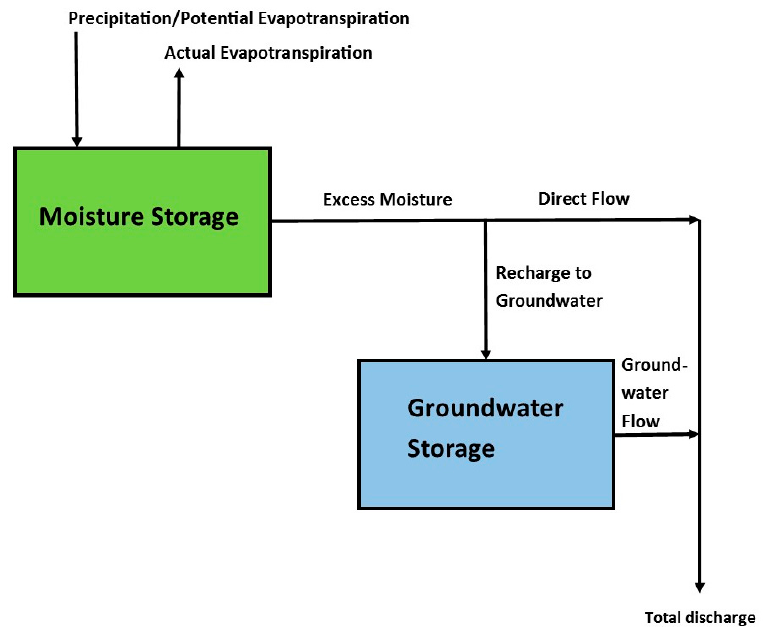
Figure 4. Model structure of the empirical rainfall runoff model, including water flows and storage system (based on Crawford and Thurin [17]).